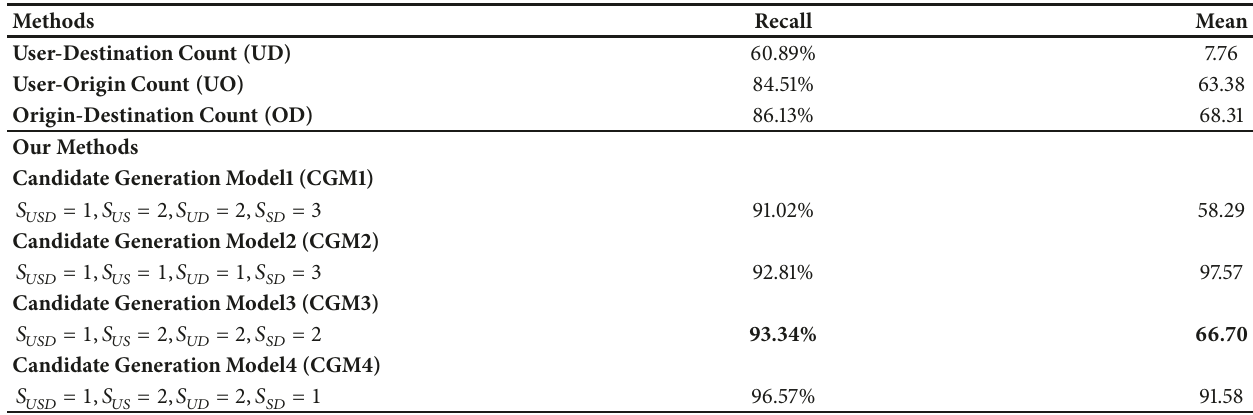
Table 6: Results of candidate generation.